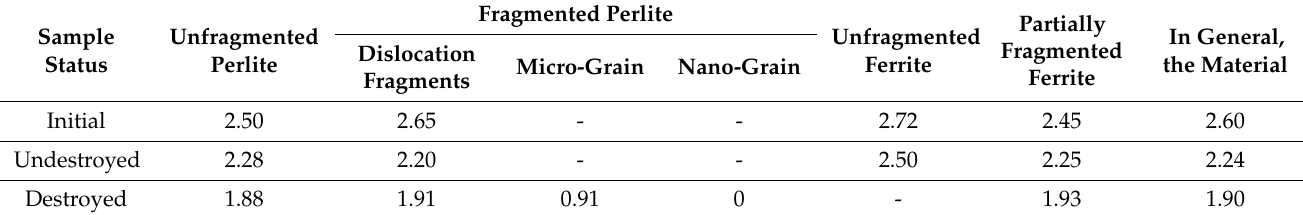
Table 3. The magnitude of the scalar density of dislocations in various morphological components of the fine structure and in the whole material ( ρ × 10 − 10 cm − 2 ).